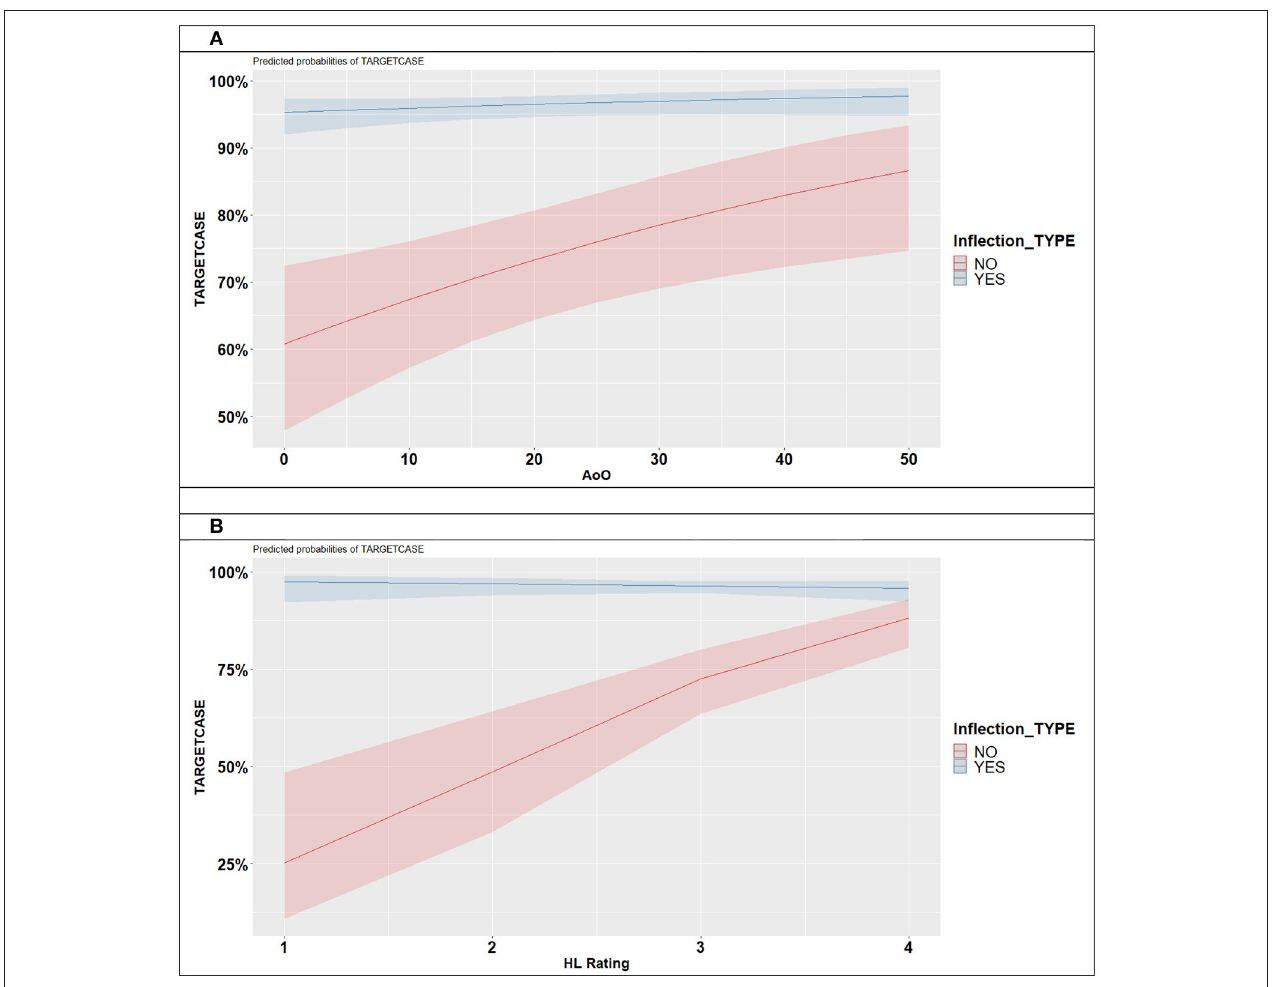
FIGURE 5 | (A) Predicted case production by inflection type by AoO. (B) Predicted case production by inflection type by HL rating.